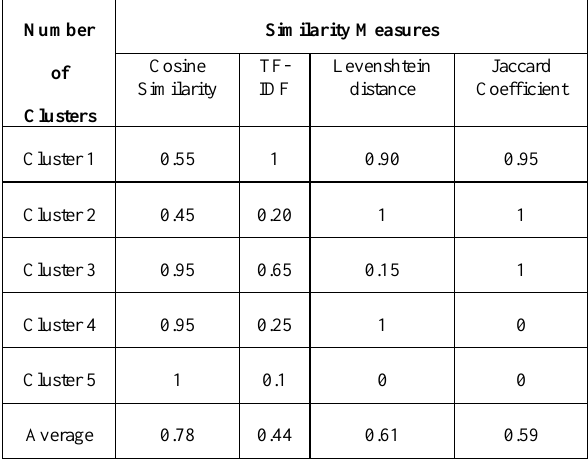
Table 12 Result of Similarity Measures after Pre-Processing